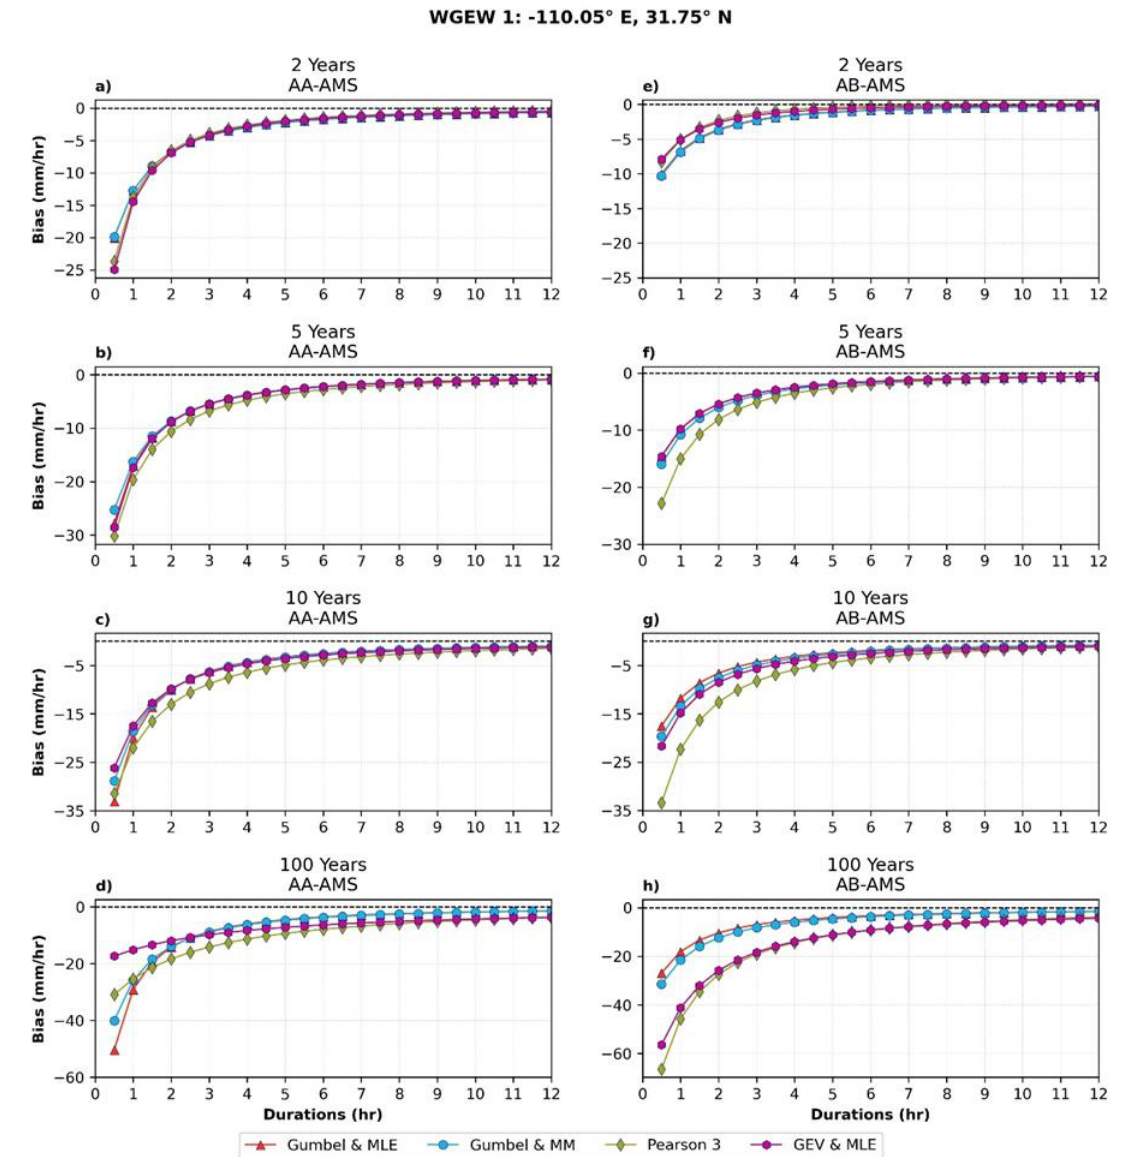
Figure 9. Precipitation intensity biases between IMERG IDFs and the gauge-based IDFs for 2, 5, 10, and 100 year return periods and event durations between 0.5 and 12 h over the WGEW 1. IMERG IDF vs. AA-AMS IDF ( left ) and IMERG IDF vs. AB-AMS IDF ( right ).